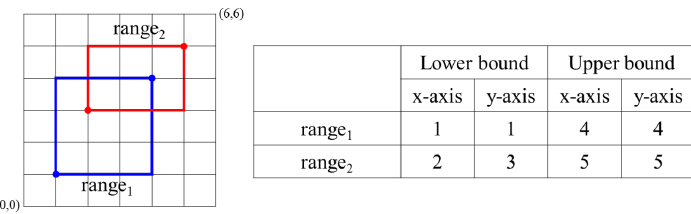
Figure 4. Overlapping between E( range 1 ) and E( range 2 )